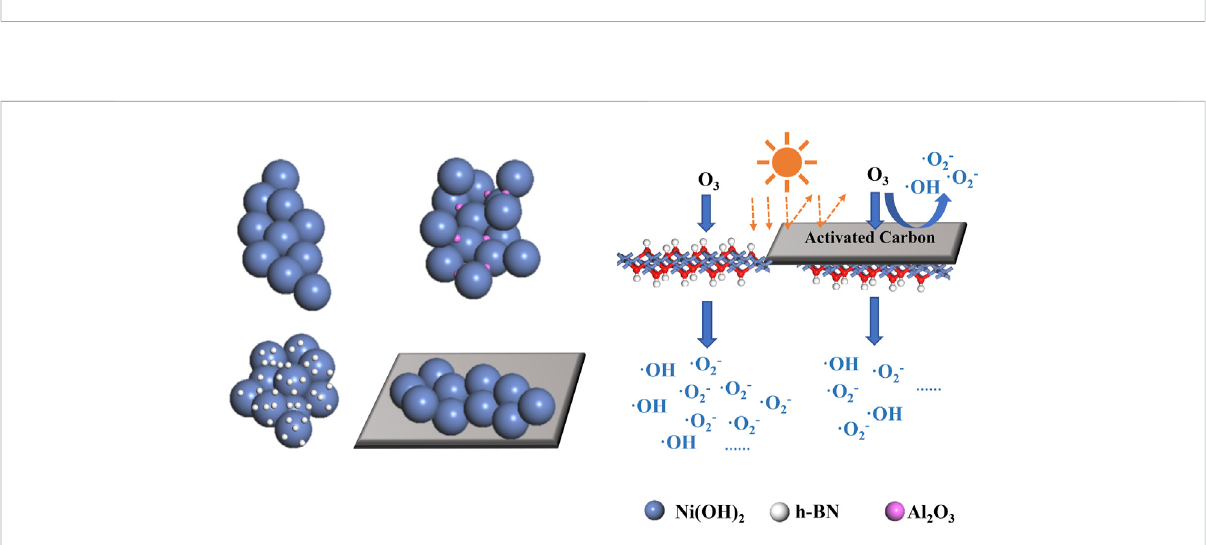
FIGURE 14 Microscopic mechanisms for effects of different carriers on the catalytic performance of α -Ni(OH) 2